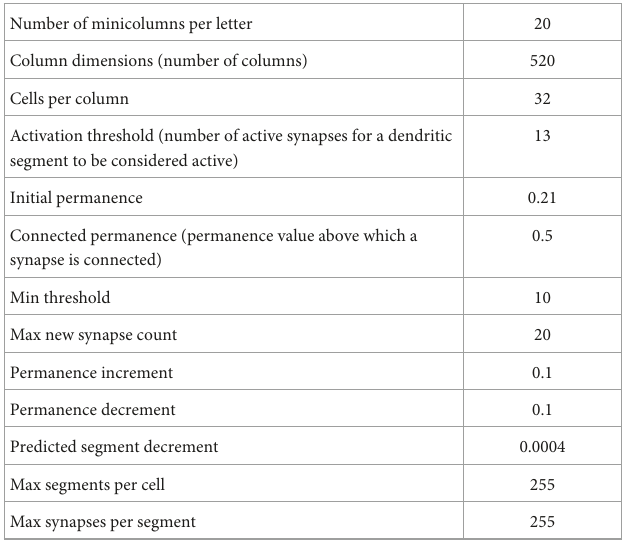
TABLE 1 Default parameter values of temporal memory (TM) model. Number of minicolumns per